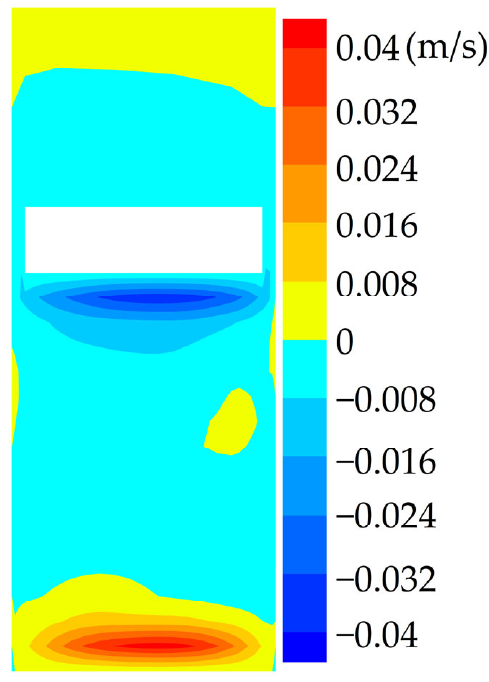
Figure 8. Contour variation of deflected flow velocity.